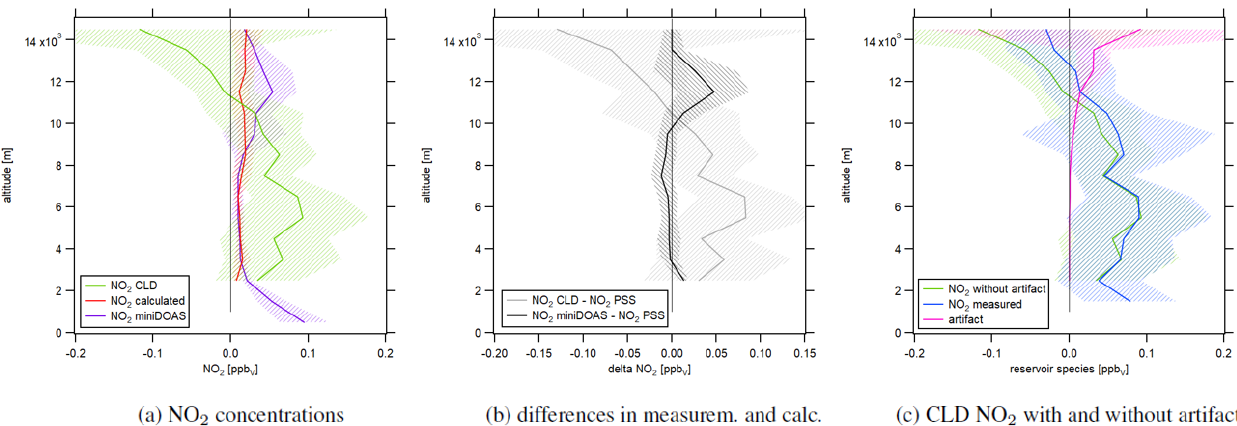
Figure 4. Vertical profiles of (a) NO 2 concentrations measured by the CLD, measured by miniDOAS and calculated via Eq. (5). (b) The difference in NO 2 concentrations from PSS calculations and measurements and (c) CLD NO 2 concentrations with and without an artifact. The shaded plot areas present the 1 σ standard deviation resulting from averaging concentrations at each considered altitude